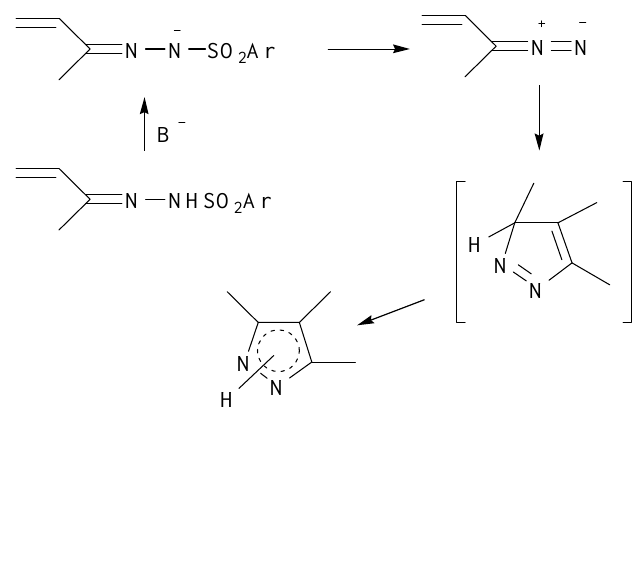
Scheme 1. Reaction mechanism for intramolecular 1,3-dipolar cycloaddition of tosylhydrazones derived from acyclic α,β -unsaturated carbonyl compounds with a β− hydrogen.